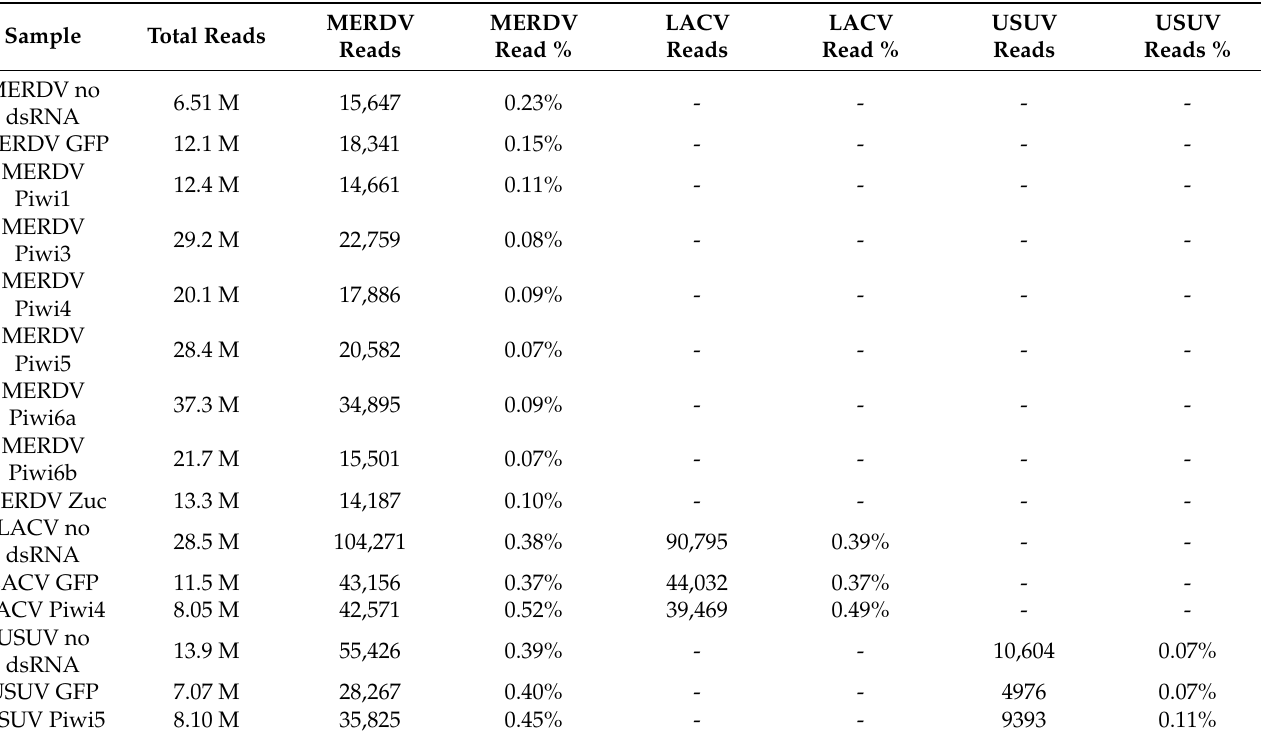
Table 4. Average sequencing read counts of all 19–32 nt reads in Cx. quinquefasciatus